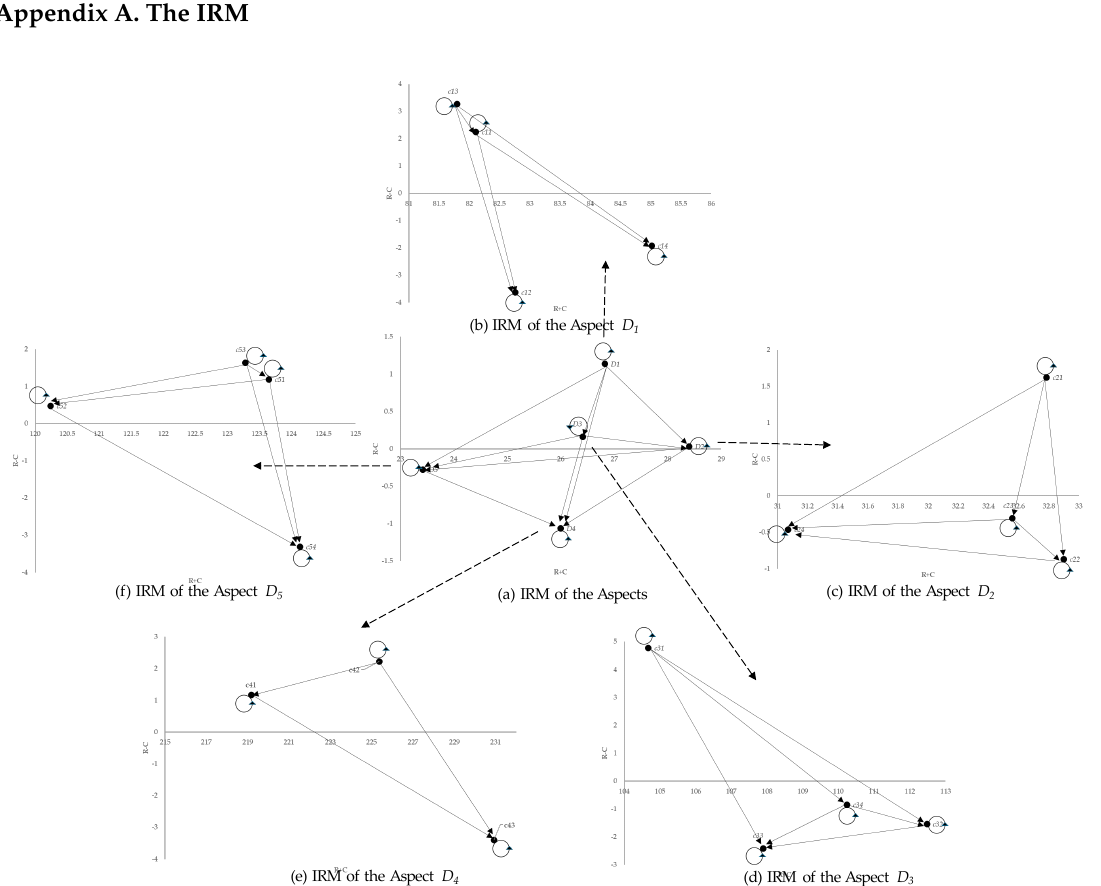
Figure A1. Causal relationship structure of total dimensions influences the heterogeneous R&D alliance strategies.